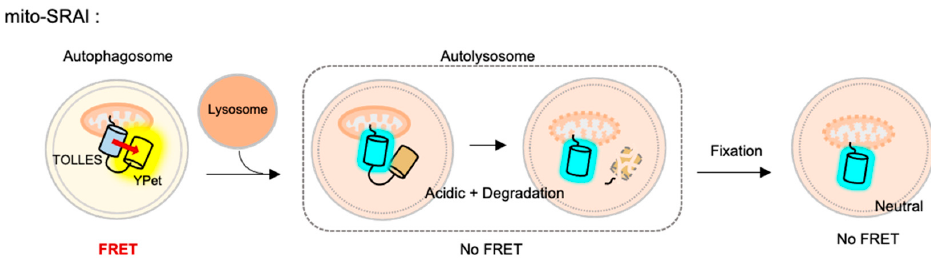
Figure 4. The fluorescence resonance energy transfer (FRET)-based mitophagy biosensor.Mito-SRAI (signal-retaining autophagy indicator) consists a sable cyan FP TOLLES (TOLerance of Lysosomal EnvironmentS) and a yellow FP YPet, as a FRET pair, and strict targeting sequences to mitochondria. Because TOLLES is stable to pH changes and lysosomal degradation, this FRET-based mitophagy sensor allows for accurate monitoring of mitophagy process in live and fixed cells. While other FRET-based autophagy biosensors were focused on different pH-sensi-